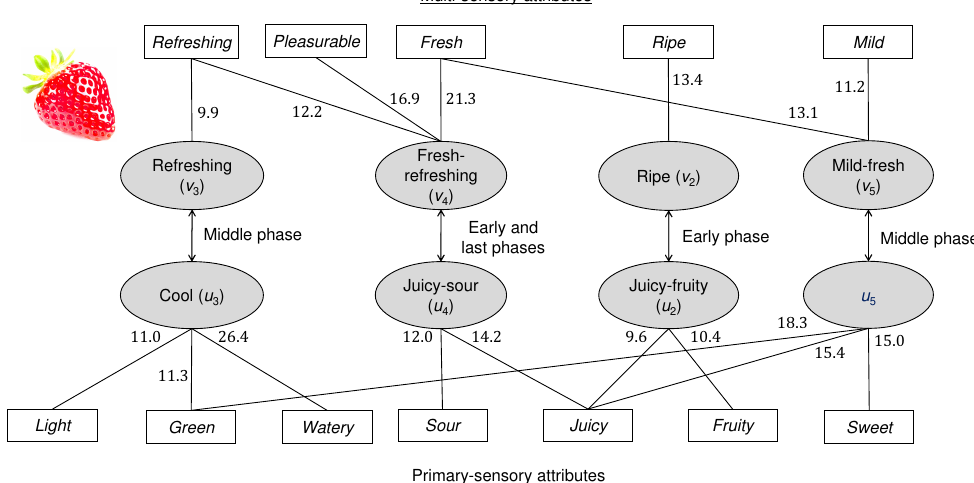
Figure 5. Trend model for strawberries. Four pairs of canonical variables are shown, except for the first canonical variables. The canonical variables were named by considering the prominent coefficients of the attributes in Table 4. The fifth canonical variable ( u 5 ) for the primary-sensory attributes is not named. The major connections are shown. Values nearby the lines indicate their